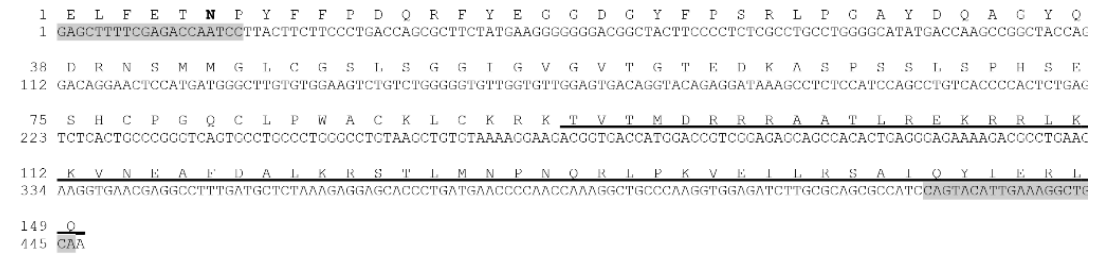
Figure 2. Pejerrey MyoG nucleotide sequence. Nucleotide fragments with grey background indicate the primers sequences (MyoG-f1, MyoG-r1). The underlined amino acid region represents the basic helix-loop-helix (bHLH) domain. A potential N-linked glycosylation site is marked in bold.